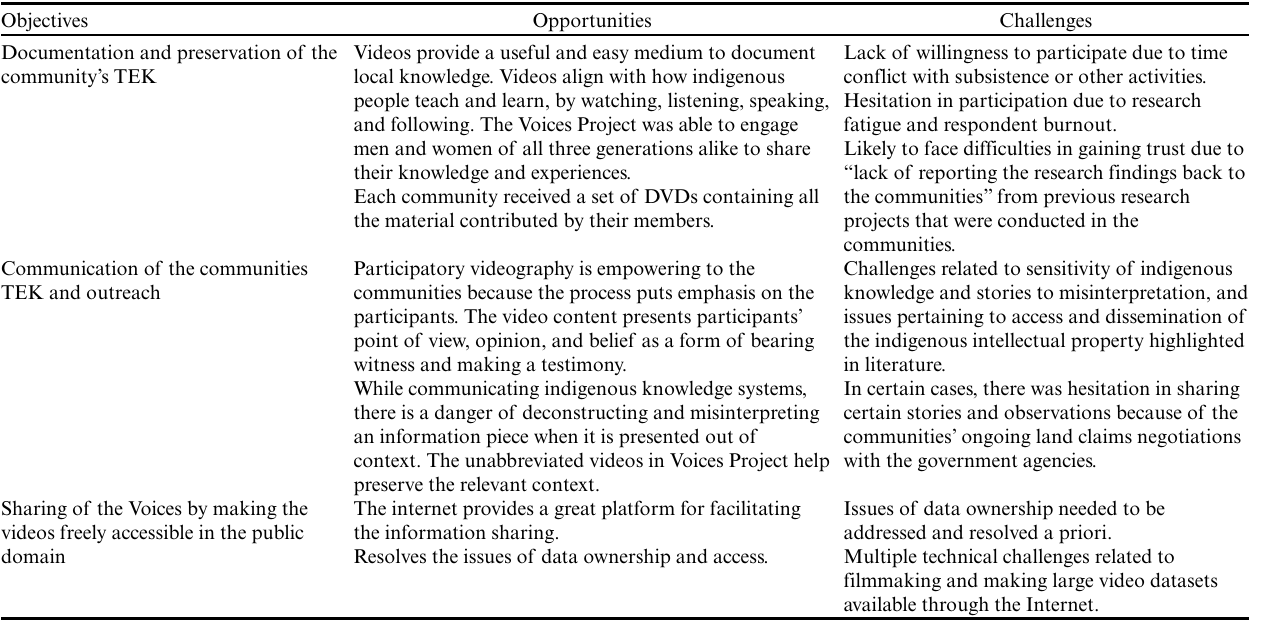
Table 4 . A performance evaluation of the Voices of the Caribou People project. TEK = traditional ecological knowledge.